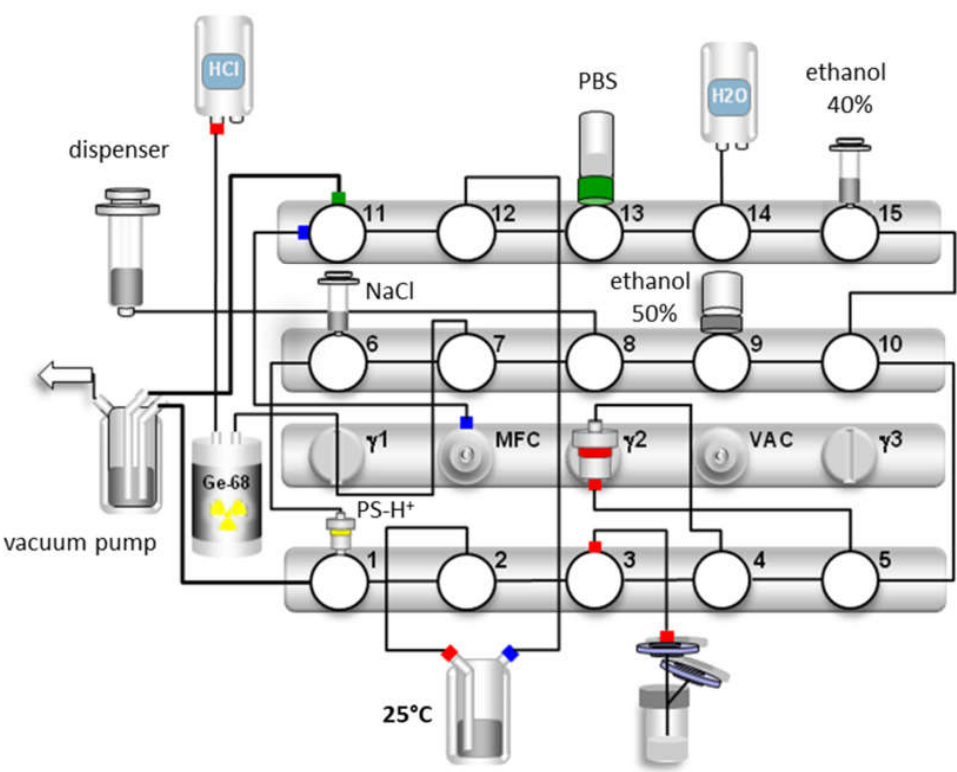
Figure 5. Synthesis scheme for [ 68 Ga]Ga-TEoS-DAZA. For the production [ 68 Ga]Ga-TMoS-DAZA, the synthetic procedure is identical, with the exception that the elution of the by-product from